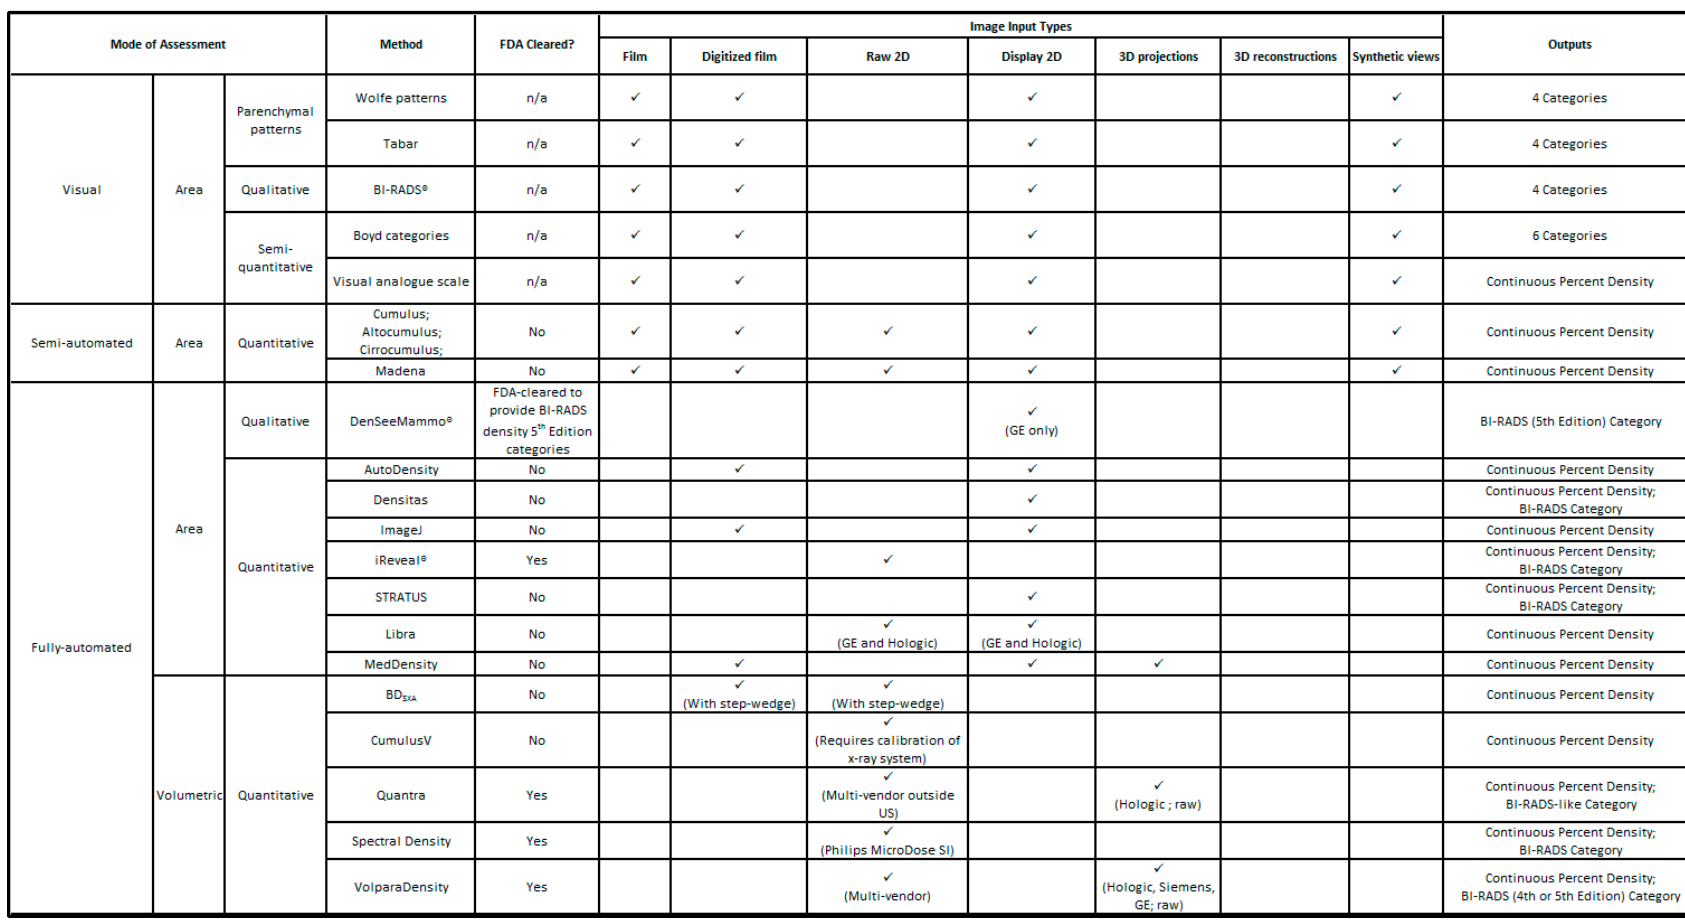
Figure 1. Mammographic Breast Density (MBD) Assessment Methods. Check marks denote that the method runs on the specified image input type; n/a: not applicable.